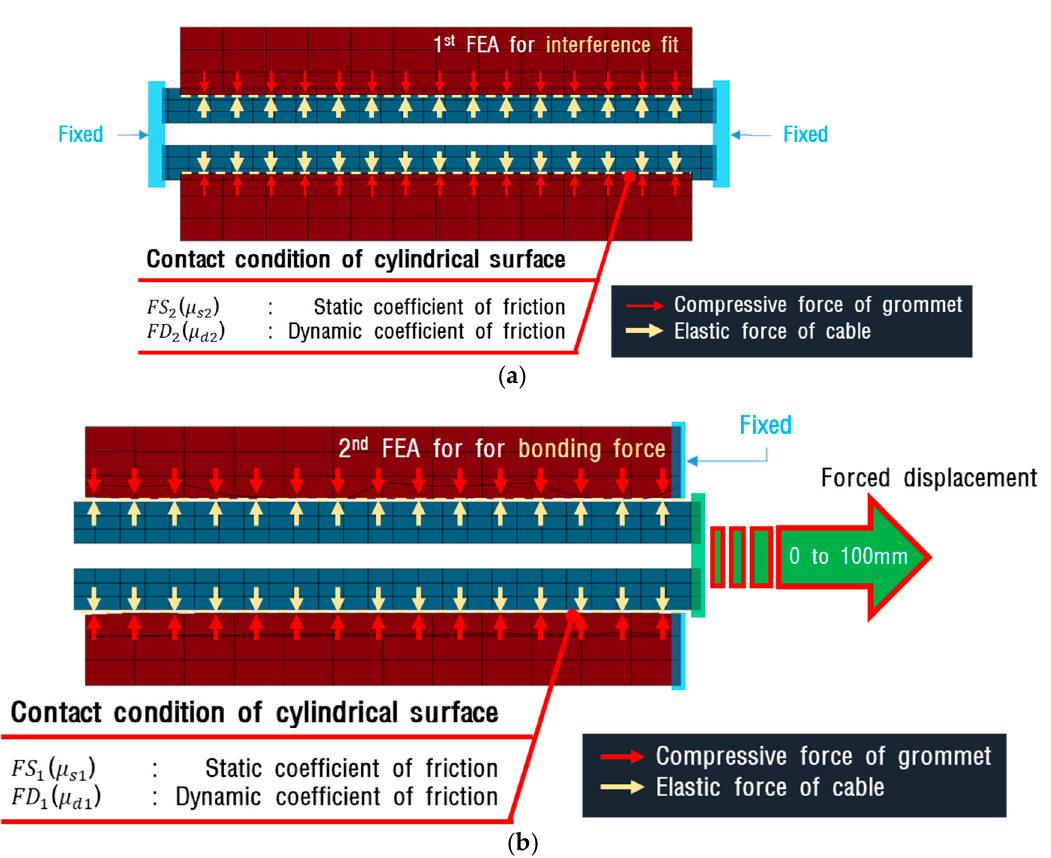
Figure 12. Results of interference fit analysis of the cable for the grommet model; ( a ) The concept diagram of analysis for interference fit; ( b ) The concept diagram of analysis for bonding force.